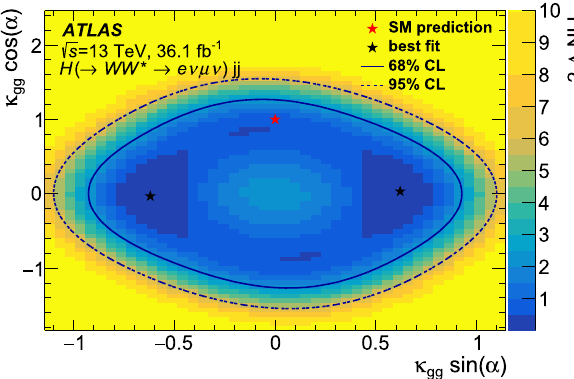
Fig. 6 68% and 95% CL two-dimensional likelihood contours of the CP-even and CP-odd coupling parameters κ gg cos (α) and κ gg sin (α) . The minima are represented by black stars, while the SM point is shown as a red star